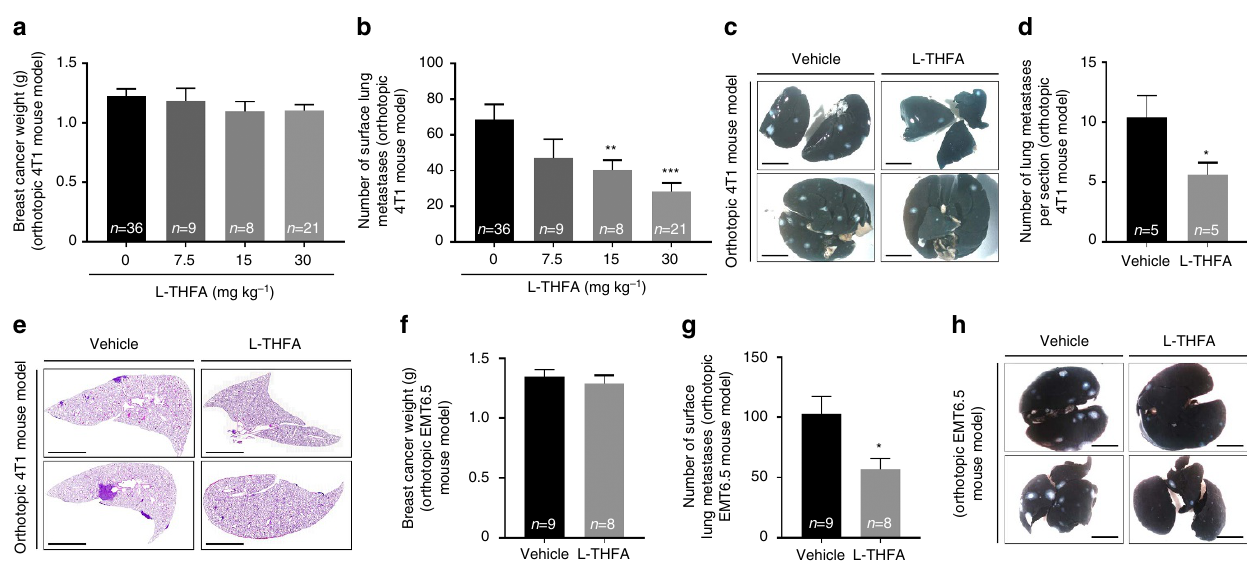
Figure 7 | Prodh inhibition impairs lung metastases formation. ( a ) Primary tumour weight, ( b ) the number of surface lung metastases and ( c ) representative pictures of ink-stained lungs with white tissue indicating metastases of BALB/c mice orthotopically injected with murine 4T1 breast cancer cells treated with vehicle or L-THFA at different concentrations for 16 days: 0mgkg (cid:2) 1 ( n ¼ 36, 4 independent cohorts), 7.5mgkg (cid:2) 1 ( n ¼ 9), 15mgkg (cid:2) 1 ( n ¼ 8), and 30mgkg (cid:2) 1 ( n ¼ 21, 3 independent cohorts). Treatment was started after primary breast tumours were formed. Scale bar: 0.5cm. Two-tailed unpaired Student’s T -test with Welch’s correction was performed. ** P r 0.01; *** P r 0.001. ( d ) Number of lung metastases per lung section and ( e ) representative pictures of H&E-stained lung sections of BALB/c mice orthotopically injected with murine 4T1 breast cancer cells treated with vehicle or L-THFA at 30mgkg (cid:2) 1 ( n ¼ 5 per condition). Scale bar: 2.7mm. Two-tailed Student’s T -test with F -testing to confirm equal variance was performed. * P r 0.05. ( f ) Primary tumour weight, ( g ) the number of surface lung metastases and ( h ) representative pictures of ink-stained lungs (black) with metastases (white) of BALB/c mice orthotopically injected with murine EMT6.5 breast cancer cells treated with vehicle ( n ¼ 9) or L-THFA at 15mgkg (cid:2) 1 ( n ¼ 8) for 18 days. Scale bar: 0.5cm. Two-tailed Student’s T -test with F -testing to confirm equal variance was performed. * P r 0.05. All error bars represent s.e.m. The Acetonitrile–Methanol Extraction procedure was adapted from Rabinowitz et al. 21 . Each sample was resuspended in 1ml of precooled acetonitrile/methanol/water (40:40:20) and centrifuged (max. speed, 5min, 4 (cid:2) C). The supernatants and the protein were collected separately. By using a tissue lyser, a mechanical disruption step was performed after resuspension of the cell pellet with the chemicals of the respective extraction method at (cid:2) 40 (cid:2) C for 5min. The extracts were dried using a vacuum concentrator. Fatty acids were dried at 20 (cid:2) C for 1h, while polar metabolites were dried at 4 (cid:2) C over night. The samples were stored at (cid:2) 80 (cid:2) C. Gas chromatography–mass spectrometric analysis . Metabolites were deriva- tized and measured as described before 48 . In brief, polar metabolites were derivatized with 20mgml (cid:2) 1 methoxyamine in pyridine for 90min at 37 (cid:2) C and subsequently with N -(tert-butyldimethylsilyl)- N -methyl-trifluoroacetamide, with 1% tert-butyldimethylchlorosilane for 60min at 60 (cid:2) C. Fatty acids were esterified with sulfuric acid/methanol for 72h at 60 (cid:2) C and then extracted with hexane. Metabolites were measured with a 7890A GC system (Agilent Technologies) combined with a 5975C Inert MS system (Agilent Technologies). One microlitre of samples was injected in splitless mode with an inlet temperature of 270 (cid:2) C onto a DB35MS column. The carrier gas was helium with a flow rate of 1mlmin (cid:2) 1 . For the measurement of polar metabolites, the GC oven was held at 100 (cid:2) C for 3min and then ramped to 300 (cid:2) C with a gradient of 2.5 (cid:2) Cmin (cid:2) 1 . For the measurement of fatty acids, the oven was held at 80 (cid:2) C for 1min and ramped with 5 (cid:2) Cmin (cid:2) 1 to 300 (cid:2) C. The MS system was operated under electron impact ionization at 70eV and a mass range of 100–650a.m.u. was scanned. Mass distribution vectors were extracted from the raw ion chromatograms using a custom Matlab M-file, which applies consistent integration bounds and baseline correction to each ion. Moreover, we corrected for naturally occurring isotopes using the method of Fernandez et al. 49 . Total contribution of carbon was calculated using the following equation 18 :